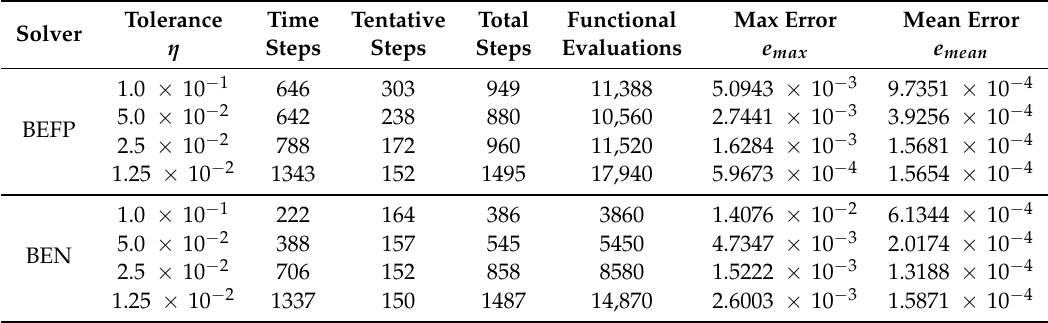
Table 7. Results of the shifted linear iterative splitting for the MCDB equation with µ = 5. Solver